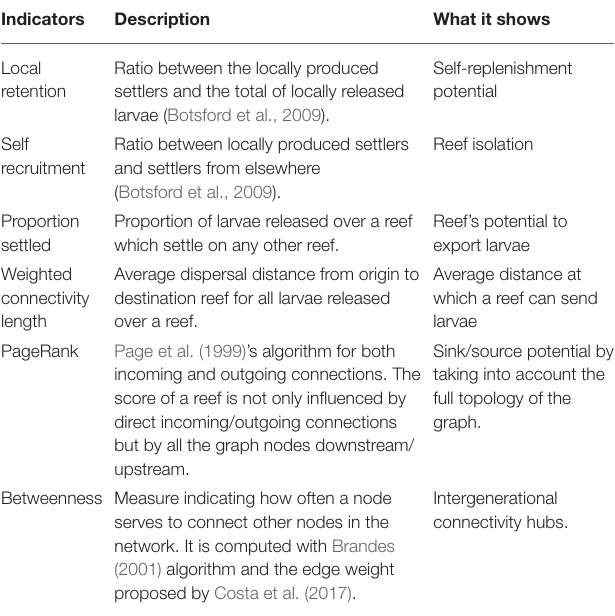
TABLE 1 | Indicators used to quantify the connectivity patterns in the FRT. Indicators Description Local